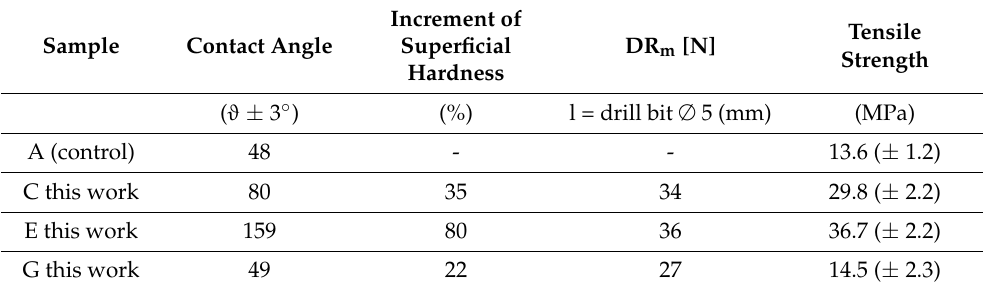
Table 7. Characterization of untreated and treated Pietraforte samples in terms of cohesion